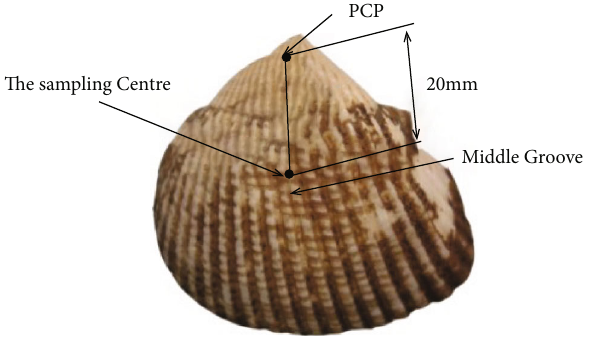
Figure 1: Surface structure of Scapharca subcrenata